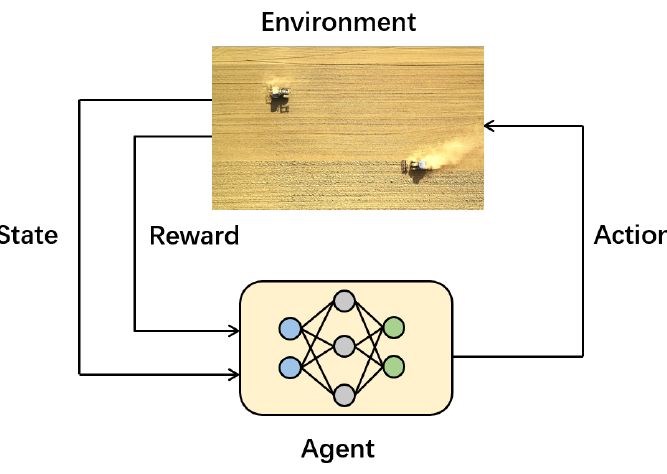
Figure 1. The framework of reinforcement